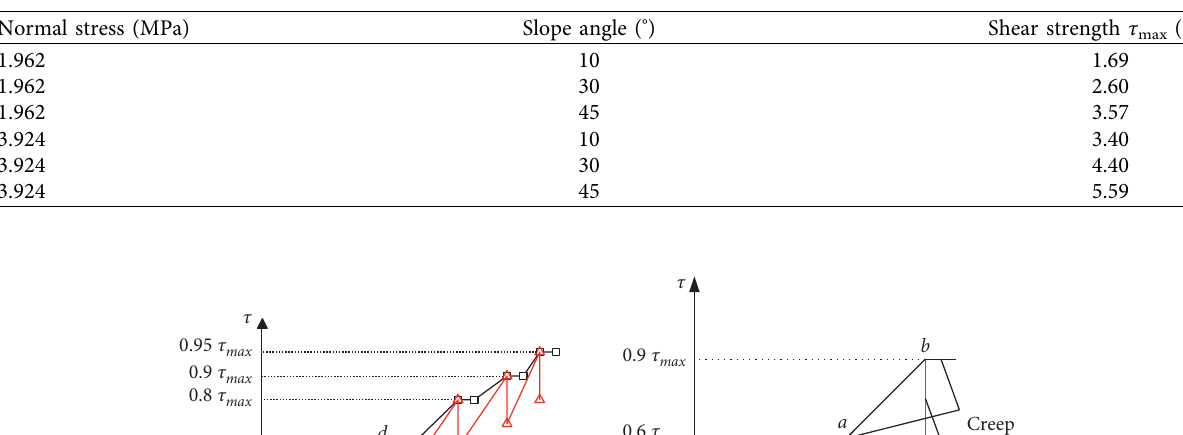
Table 1: Average shear strength of structural